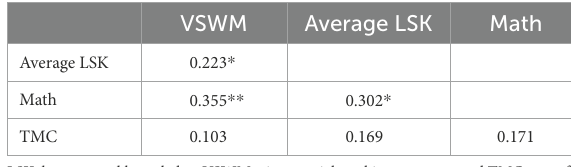
TABLE 4 Results from Spearman’s Rho bivariate correlation analysis ( N = 85).